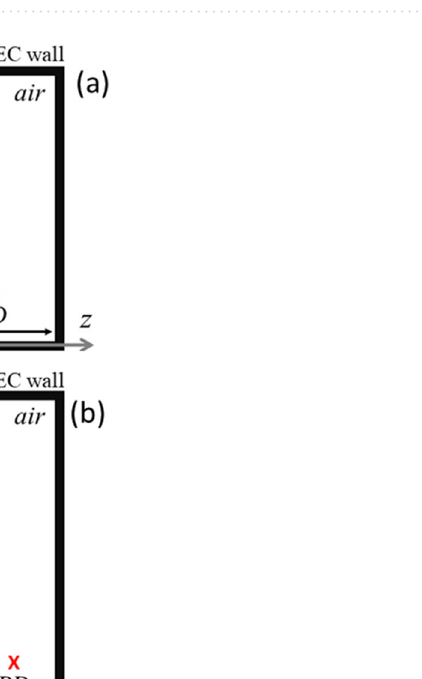
Figure 3. The estimated location versus the actual location of PD sources for the 2D transformer model shown in Fig. 1. The number of Monte-Carlo simulations is 100, ( a ) x-coordinate, ( b ) y-coordinate.